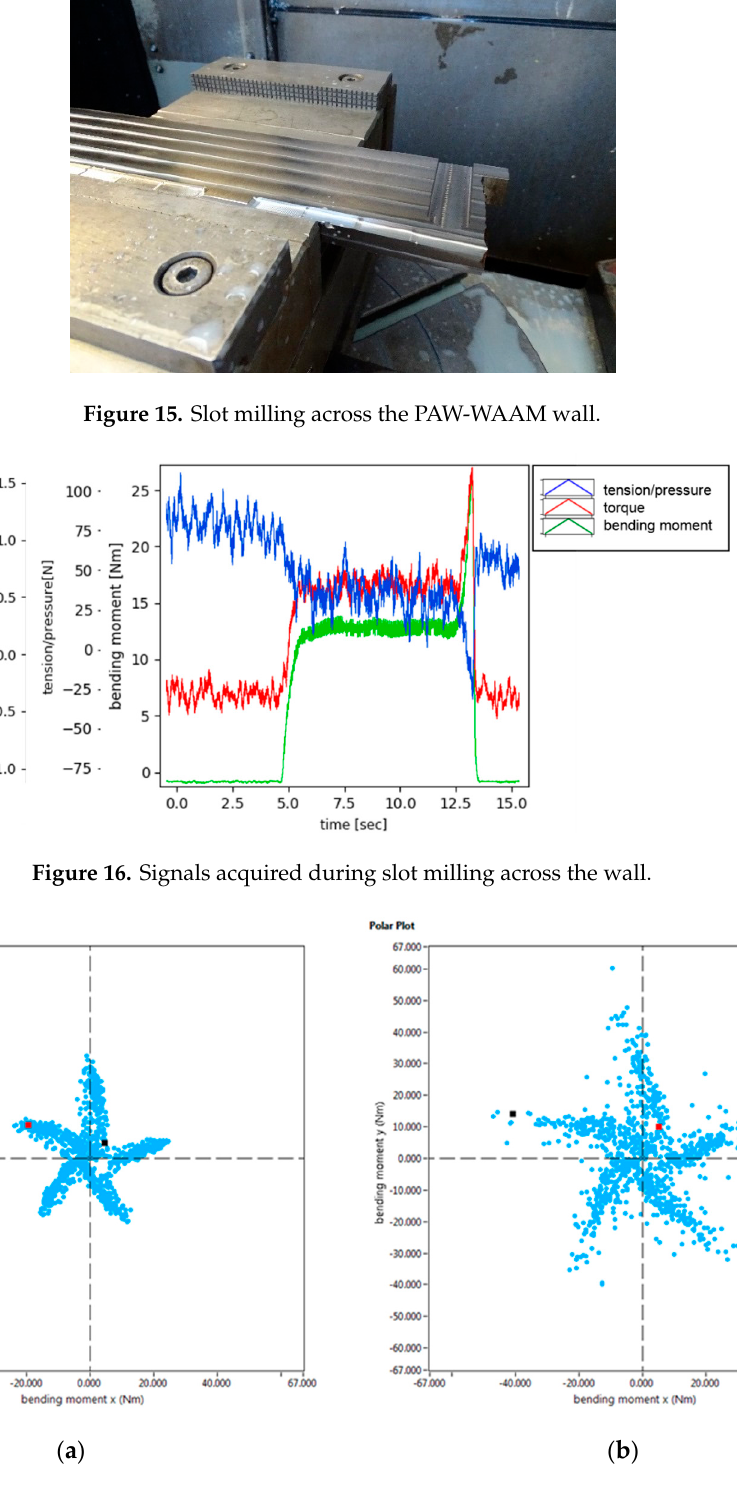
Figure 17. Polar plot of the average bending moment in the slot milling experiments: ( a ) normal behavior of the bending moment; ( b ) Polar diagram during the breakage of the teeth.